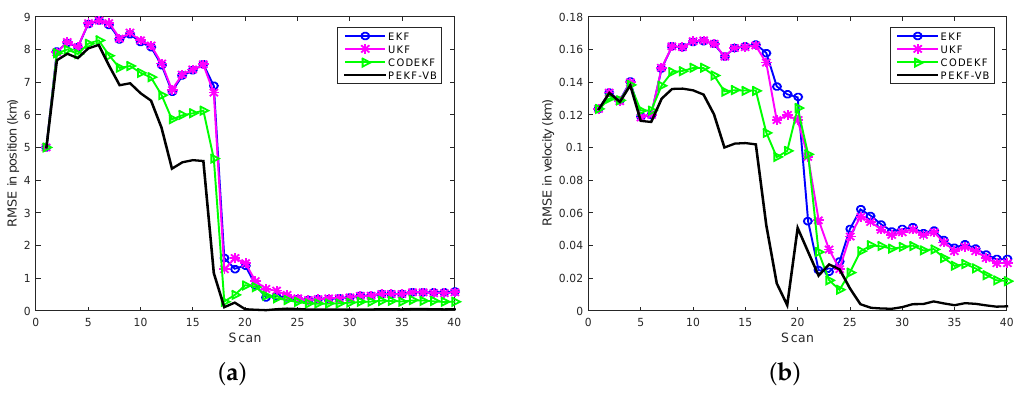
Figure 6. RMSE comparison of EKF, UKF, CODEKF and PEKF-VB in bearing-only tracking. ( a ) RMSE in position ( b ) RMSE in velocity.